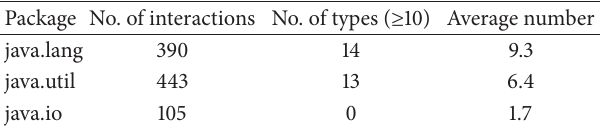
Table 3: Object interactions for target APIs. The third column is the number of types with no less than 10 interaction, and thelast column is the average number of interactions per type.